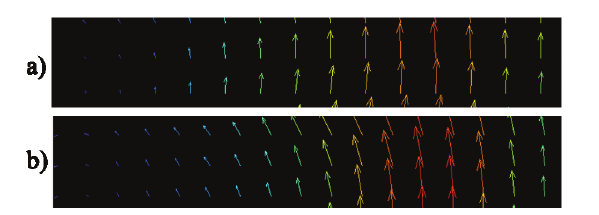
Fig. 17. Velocity vectors with CO 2 injection pressure of: a) 6 bar, b) 10 bar